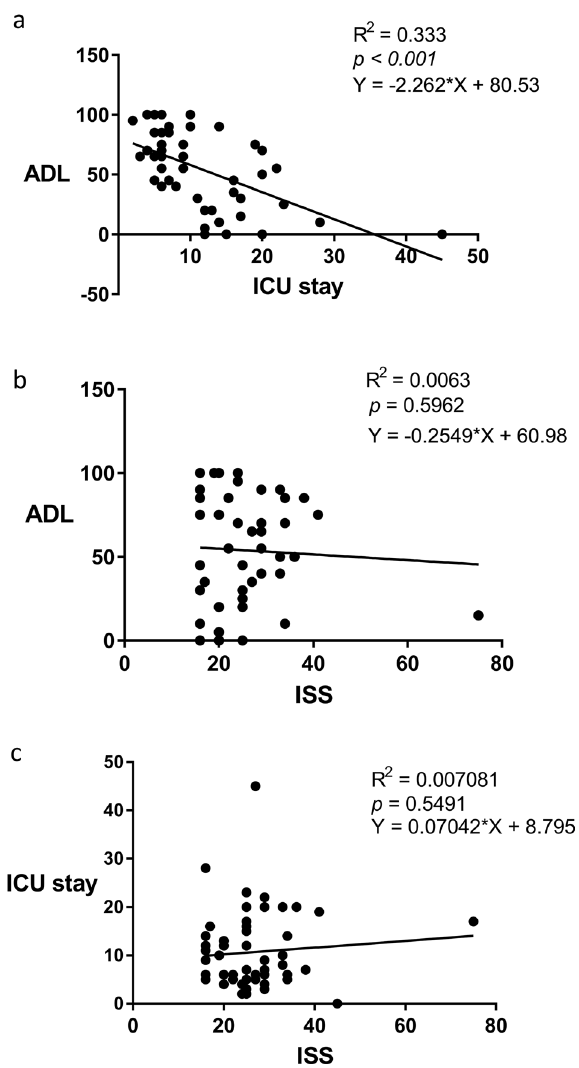
Figure 2. The correlation of ALD and ICU stay ( a ) and ISS ( b ) in trauma patients (survivors). ( c ) The correlation of ISS and ICU stay in trauma